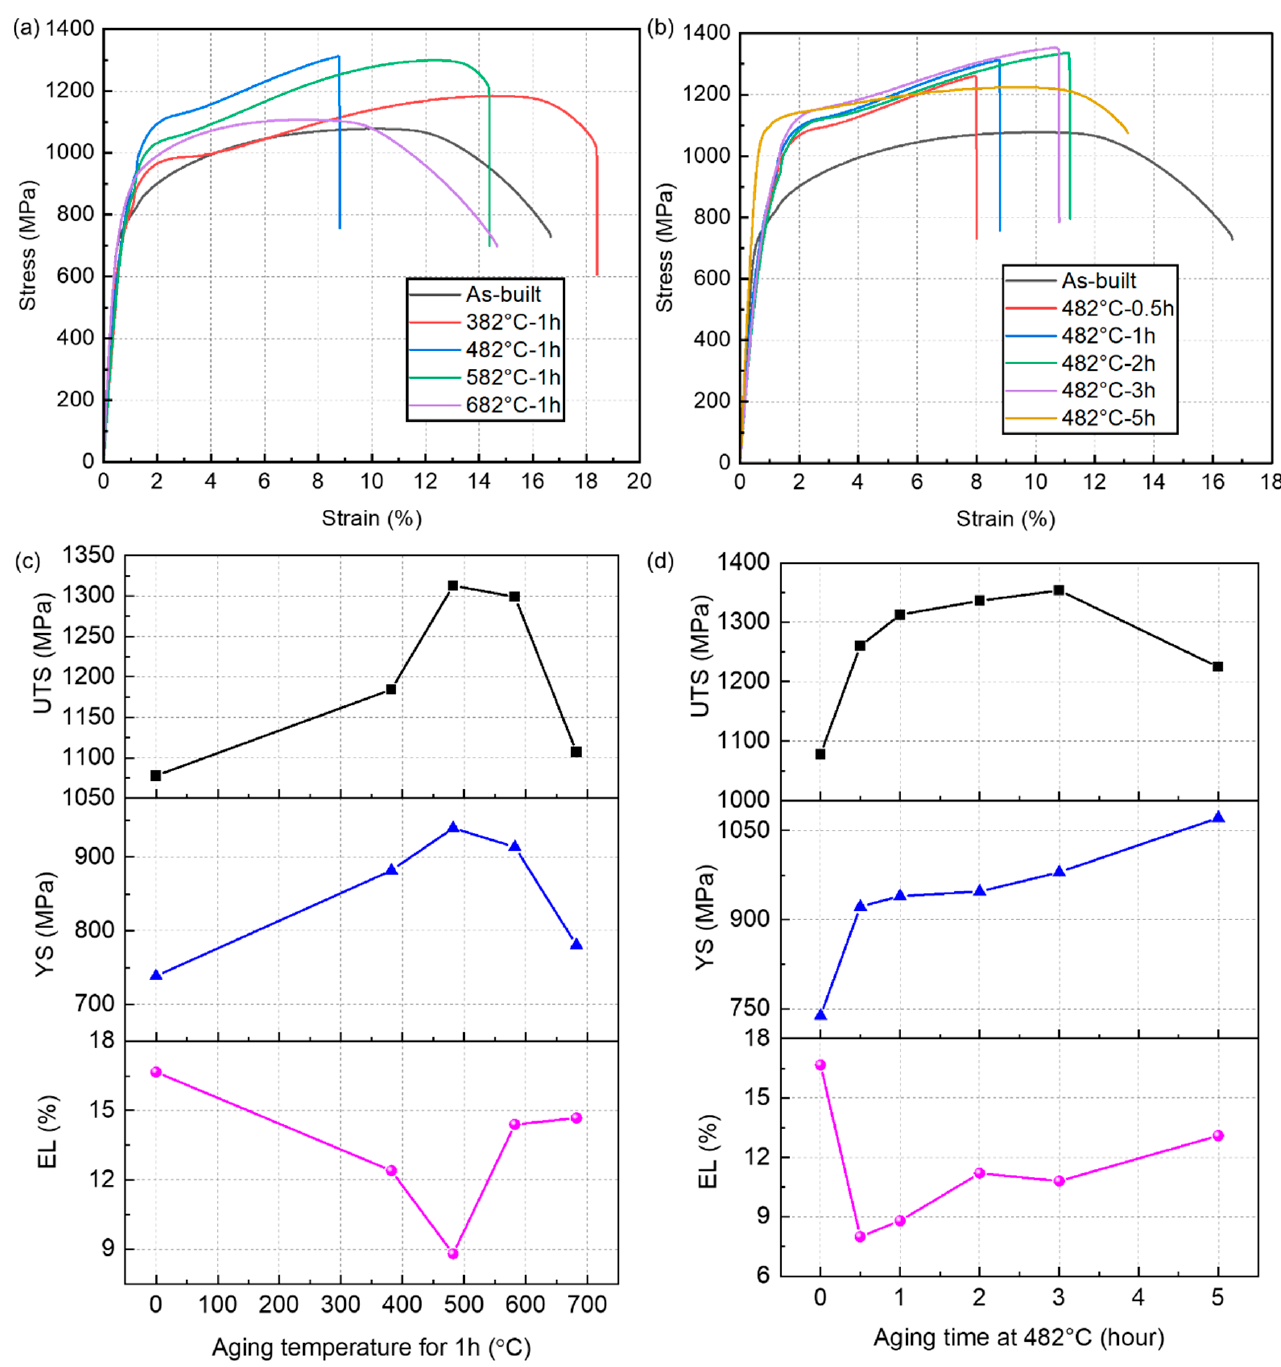
Figure 9. Mechanical properties of the SLM 17-4 PH steel samples under different post-aging treatment conditions: ( a , b ) strain-stress curves and ( c , d ) key indicator statistics. First row: mechanical properties at different aging temperatures for 1 h. Second row: mechanical properties at different aging times at 482 ◦